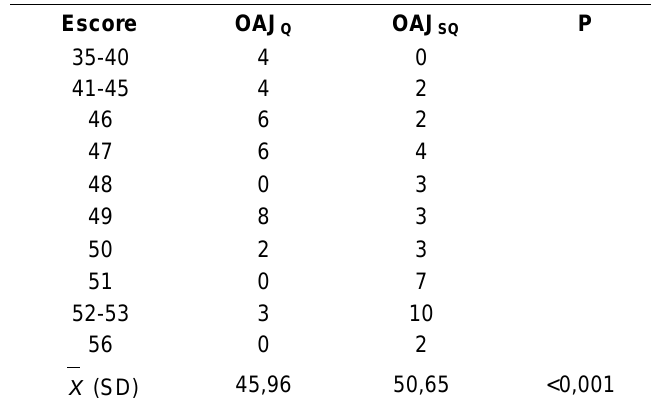
Tabela 4. Escore da EEB entre as participantes com osteoartrite de joelho com histórico de queda (OAJ sem histórico de queda (OAJ